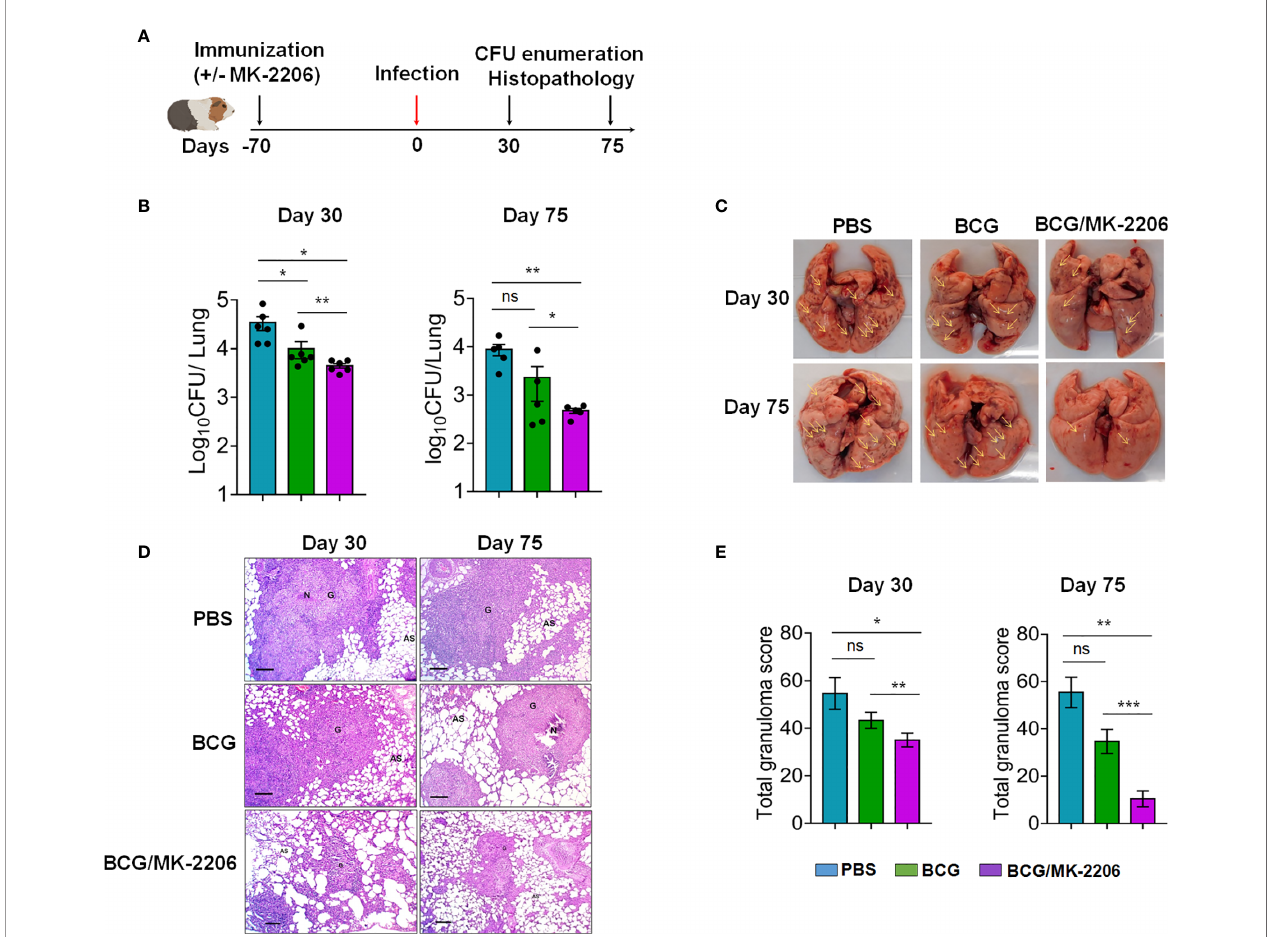
FIGURE 8 | MK-2206 ameliorates BCG elicited protection against TB in guinea pigs. (A) Schematic design of protection studies in guinea pigs. The guinea pigs were immunized as described in Materials and Methods . After 70 days post-immunization, the animals were infected via aerosol route with H37Rv strain (B) The lung bacillary load was determined in animals at day 30 and day 75 post Mtb challenge. For CFU enumeration, 10.0-fold serial dilution of homogenates are plated on 7H11 agar at 37°C for 3 to 4 weeks. The data shown is mean ± SEM of log 10 CFU obtained from a single experiment (n = 5 – 6 animals per group per time point). (C) Representative photographs of lung lobes from a representative animal for each group are shown. Yellow arrows highlight the lesions seen in these images as characterized by hemorrhages, swelling or exudative in fl ammation. (D) The section of lungs was stained with Hematoxylin-eosin (HE) and viewed at 40× magni fi cation. A representative section from each group is shown. Scale bar 200 m m. (E) The total granuloma score obtained from n = 5 – 6 animals per group was determined. The data shown in these panels is mean ± SEM of total granuloma score obtained from a single experiment (n = 5 – 6 animals per group) at day 30 and day 75 post-infection. Statistical differences were obtained for the indicated groups. *p < 0.05; **p < 0.01; ***p < 0.001; ns, non-signi fi